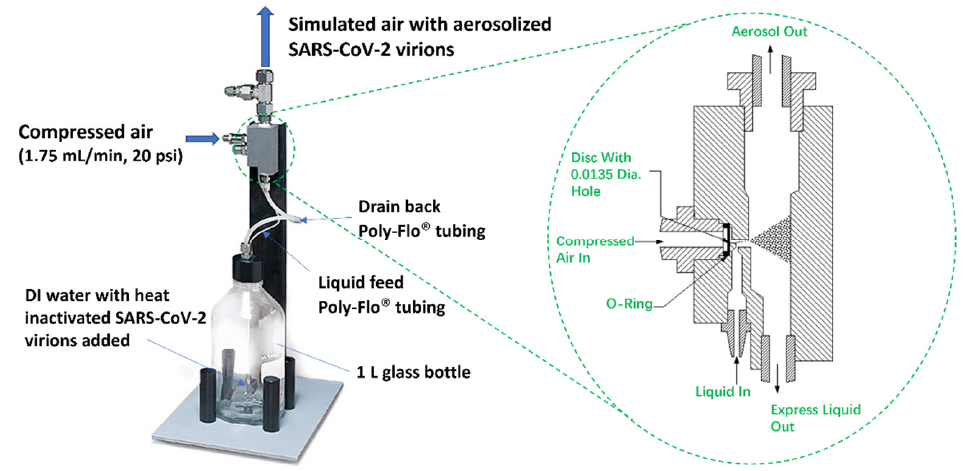
Figure 2. TSI MODEL 3076 Constant Output Atomizer used for aerosolizing heat inactivated SARS